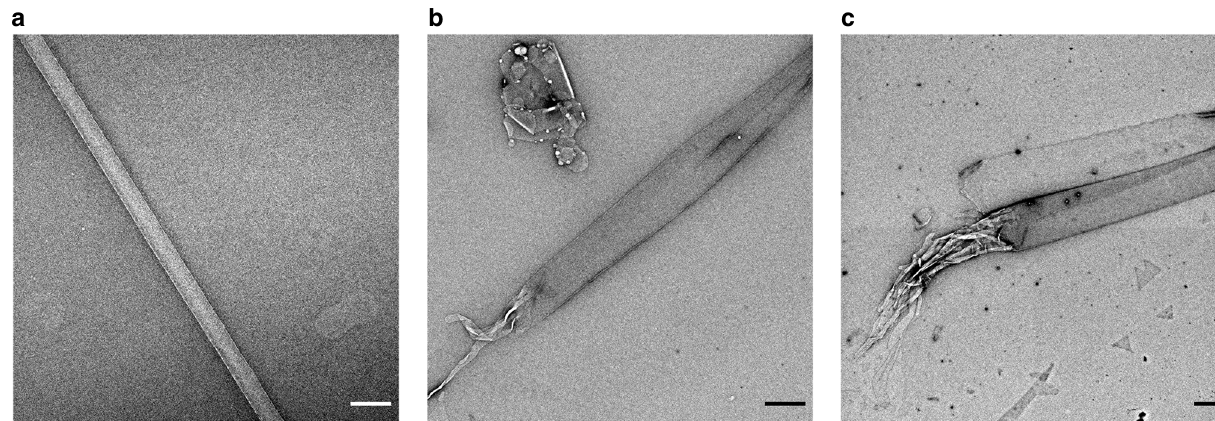
Fig. 6 Thermostability of hLL-37 17-29 fi brils. Transmission electron micrographs of 2 mM LL-37 17-29 incubated for 3 days. a The sample was heated to 60 °C for 10 min. b The sample was incubated for additional 24 h at 37 °C after the 60 °C heat shock. c The sample was heated to 80 °C for 10 min All scale bars represent 500 nm.